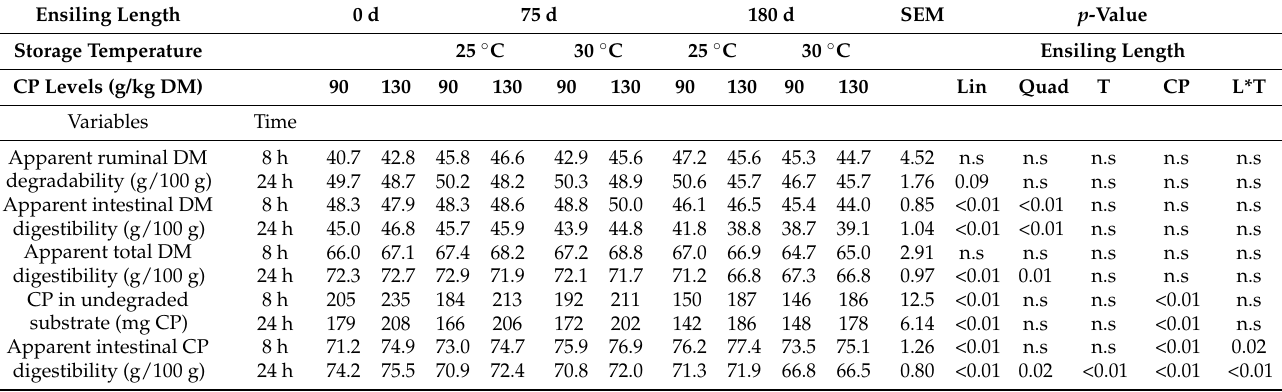
Table 5. Effect of ensiling length, storage temperature, and crude protein level on the in vitro degradability and post-ruminal digestibility of diets’ dry matter (DM) and crude protein (CP) at different incubation periods (least squares means; n =